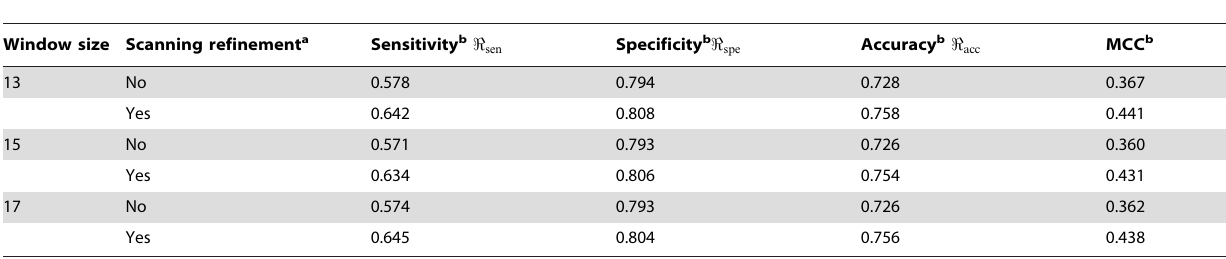
Table 2. A comparison between the predicted results with and without the scanning refinement.